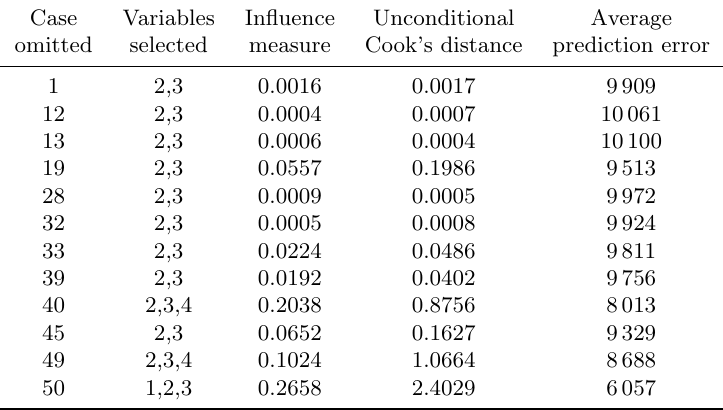
Table 1: Fuel data: Variable selection with Mallows’ C